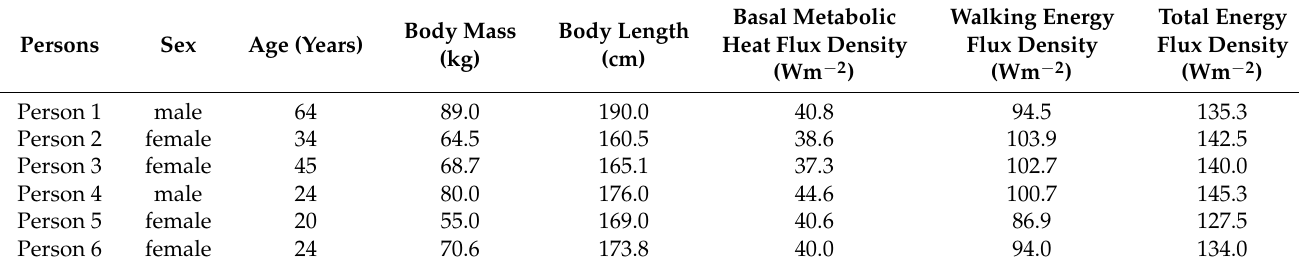
Persons Table 1. Human state variables together with M b (basal), M w (walking), M (total, M b + M w ), humans: Person 1 (P1), Person 2 (P2), Person 3 (P3), Person 4 (P4), Person 5 (P5) and Person 6 (P6).